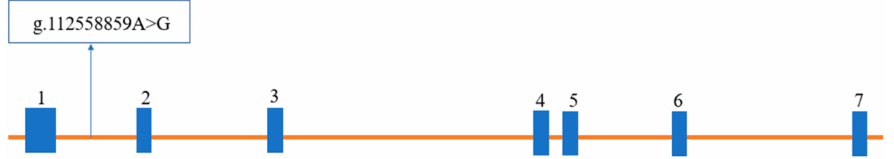
Figure 1. Schematic representation of the LCORL gene and localization of identified mutation sites. The blue rectangle represents the exon region and the orange rectangle represents the intronic region.